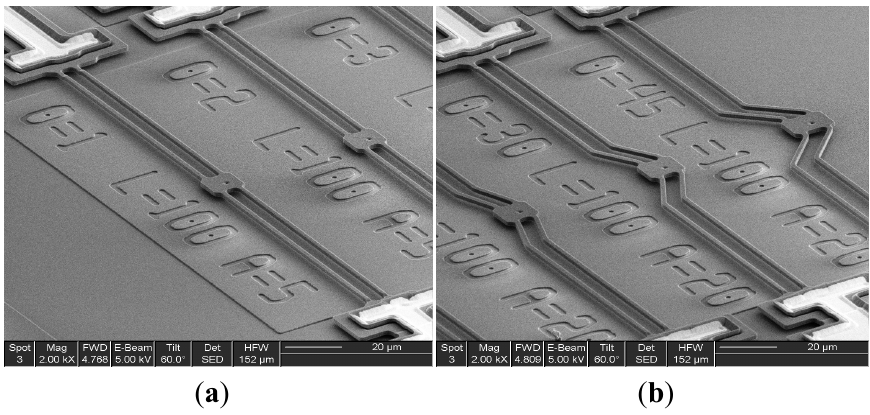
Figure 1. A scanning electron microscope (SEM) image of ( a ) a Chevron actuator, and ( b ) a Kink actuator.